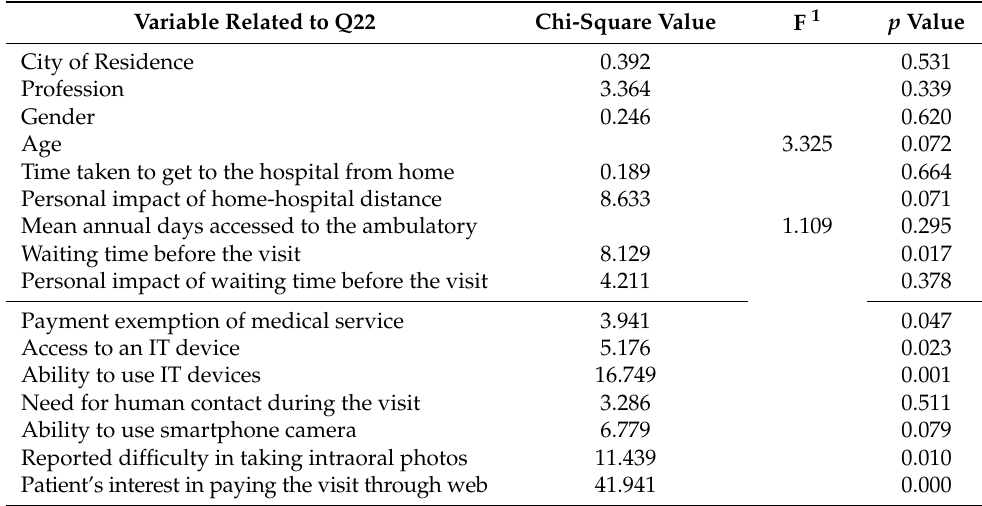
Table 3. Summary of bivariate statistical analysis carried out considering as dependent variables Question 23.